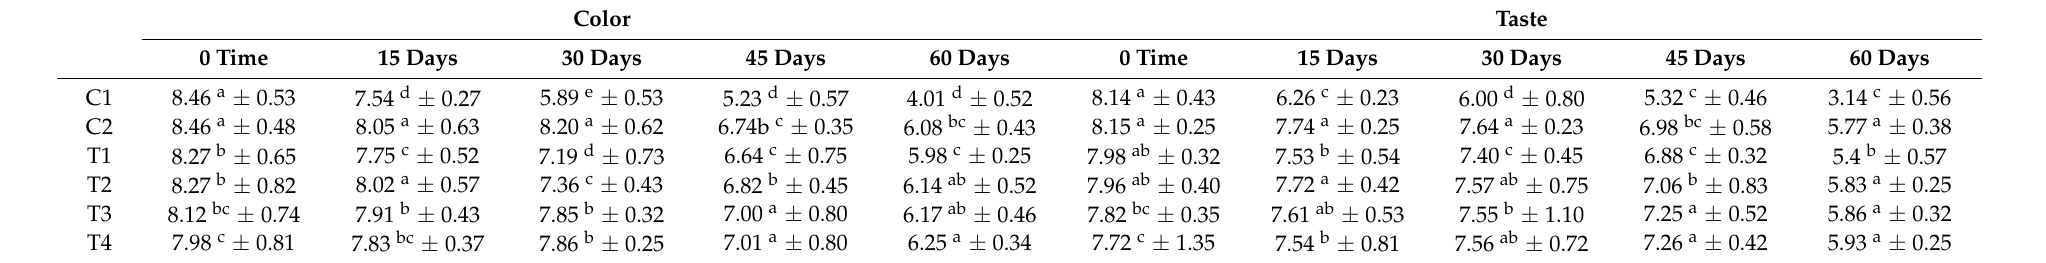
Table 10. Means of taste and color values of mayonnaise samples enriched with RCFE during storage. Color Taste